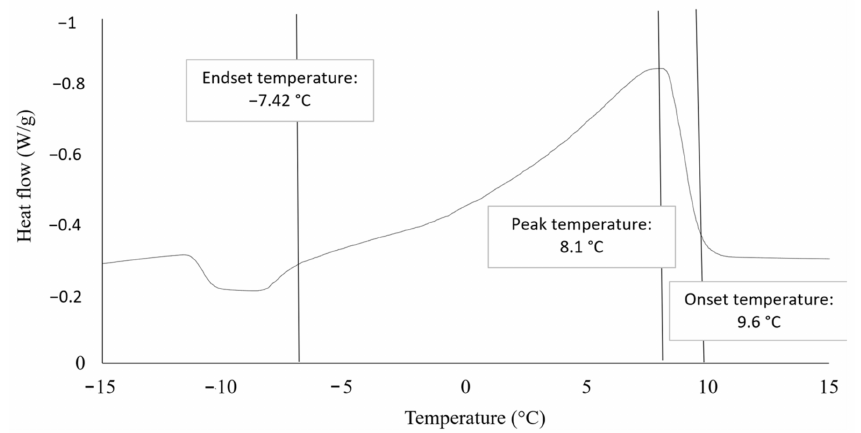
Figure 1. Graph of temperature vs. heat flow for biodiesel sample.